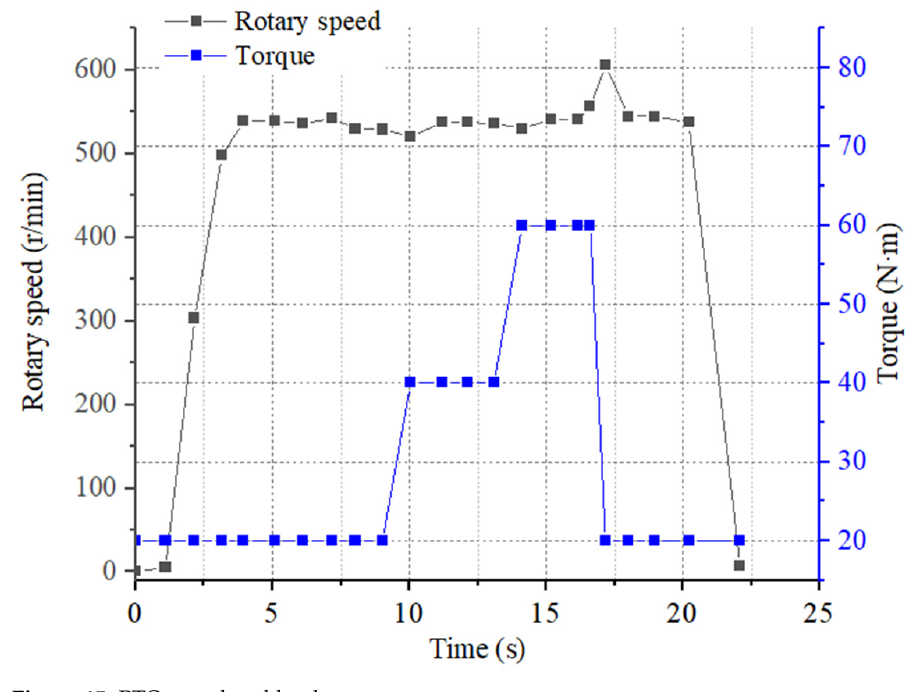
Figure 15. PTO speed and load torque curves.